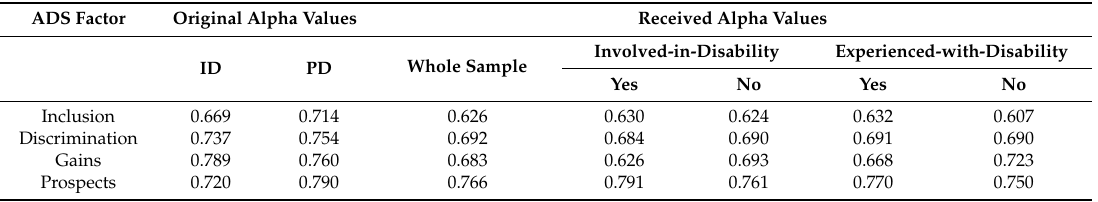
Table 4. Comparison of Cronbach’s alpha reliability coe ffi cients obtained in the original [15]